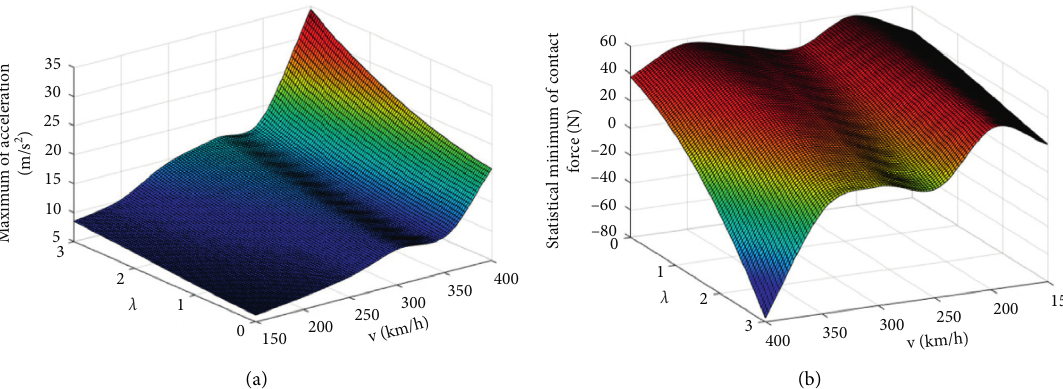
Figure 14: The influence of ice thickness on the current collection quality under different operating speeds (combinatorial material method). (a). Maximum of acceleration; (b) statistical minimum of contact